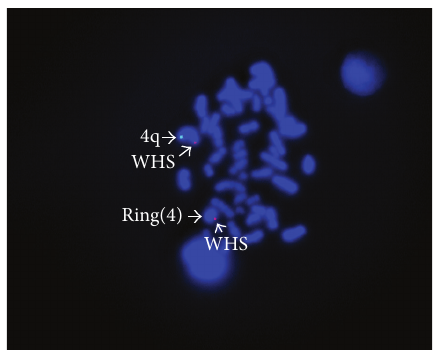
Figure 1: Partial G-banded karyotype shows normal chromosome 4 and ring chromosome 4.